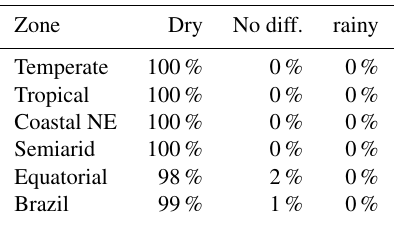
Table 5. Frequency of higher mean sunshine duration during dry and rainy